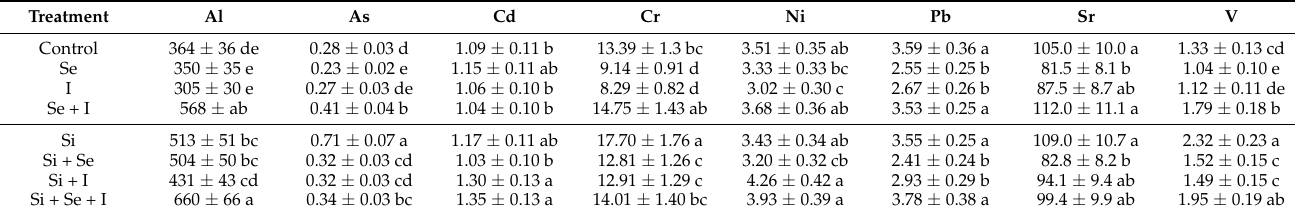
Figure 4. The most intensive relationships between the elements investigated in chervil shoots ( p < 0.001). Table 7. Levels of As, Al, Cd, Cr, Ni, Pb, Sr and V accumulation in chervil shoots under single and joint application of Se, I and Si.